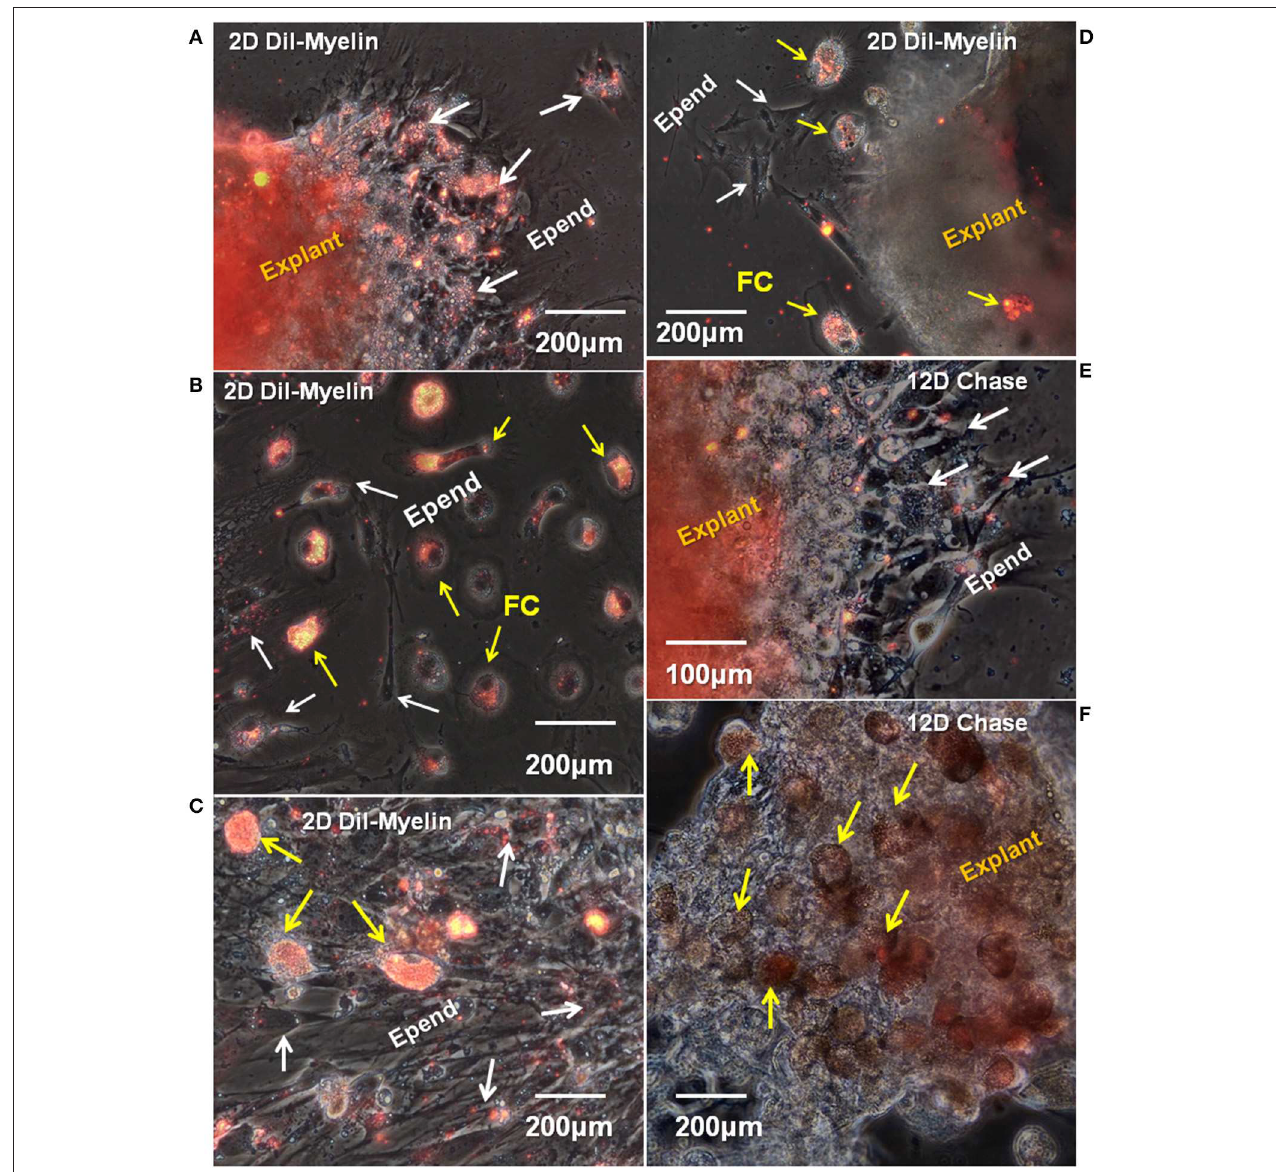
FIGURE 10 | In vitro uptake and turnover of myelin in ependymal cells and foamy macrophages. Fourteen days regenerating cord explants were cultured for 8 days, then incubated with DiI-labeled Axolotl brain myelin for an additional 2 days. A representative combination of outgrowth and explants labeling images are shown. (A) In a region with ependymal cell outgrowth only, the explants and ependymal outgrowth took up significal levels of labeled myelin fragments (white arrows). (B) In an area of mixed, dispersed foam cell and ependymal cell outgrowth, only the foam cells are heavily labeled. (C) An denser area of dispersing ependymal cells (white arrows) plus foam cells (yellow arrows) shows heavy myelin uptake in vitro only in the foam cells. (D) A sparsely labeled explants has strongly labeled foam cell outgrowth (yellow arrows) and unlabeled ependymal cells (white arrows). (E,F) Show a 12 days myelin-free chase period following 2 days of DiI-Axolotl-myelin uptake. (E) Shows part of the same region shown in (A) . Labeled myelin in the ependymal outgrowth is greatly reduced (white arrows). The explants is still labeled. (F) Even after the 12 days chase period, foam cells. D, day; Epend, ependymal; FC, foam cell. Magnification bar is shown in the lower portion of each image.